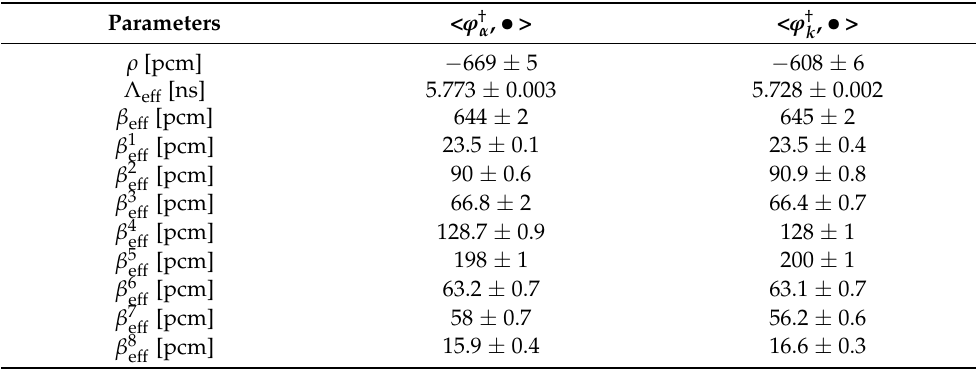
Effective kinetics parameters of Problem I, sub-critical configuration including delayed contributions.